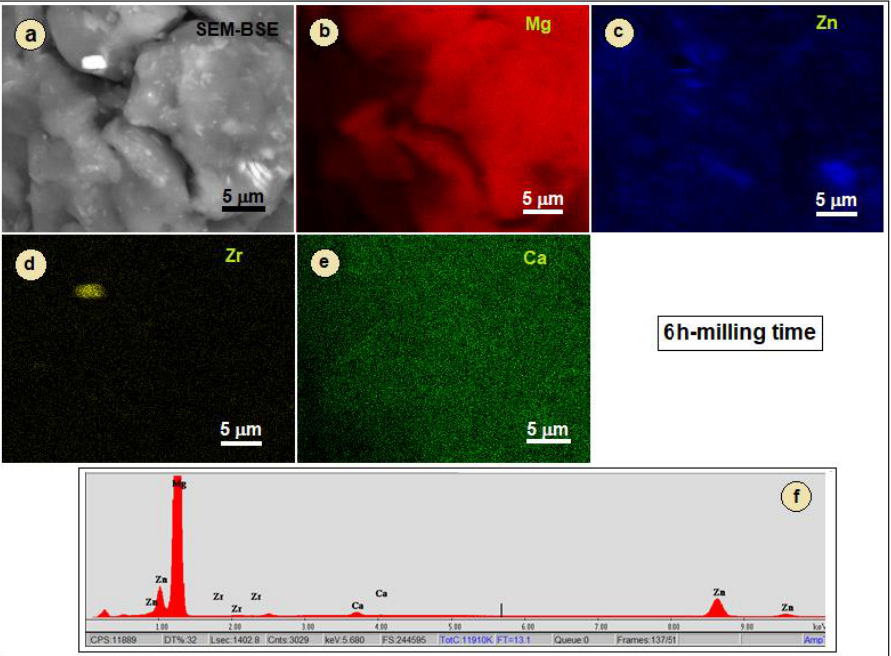
Figure 9. Distribution map of alloying elements for the powder-alloy processed by mechanical alloying at 6 h/300 rpm: ( a ) SEM image of the powder; ( b ) SEM-EDS distribution of Mg; ( c ) SEM-EDS distribution of Zn; ( d ) SEM-EDS distribution of Zr; ( e ) SEM-EDS distribution of Ca; ( f ) global EDS spectra.